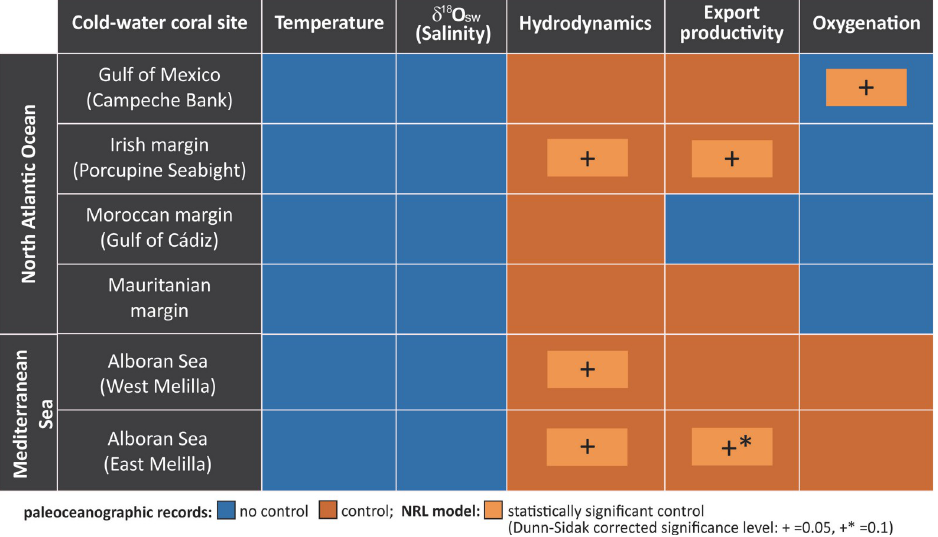
Fig 4. The key environmental driver matrix. Summary of environmental parameters controlling the occurrence of the Lophelia pertusa in the North Atlantic and the Mediterranean Sea over the last 20 kyr (blue: no control, orange: control; based on paleoceanographic proxy data). Applying the NLR model to the paleoceanographic records of the selected environmental parameters in combination with records of L . pertusa occurrence enables us to identify which parameters had the most impact on coral development, i.e., triggering the onset or demise of CWC proliferation. The underlying data for this figure can be found in https://doi.org/10.1594/PANGAEA.932775. NLR, nominal logistic